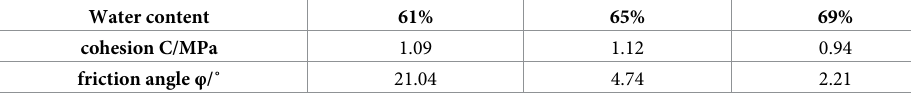
Table 3. Relations between cohesion, friction angle and water